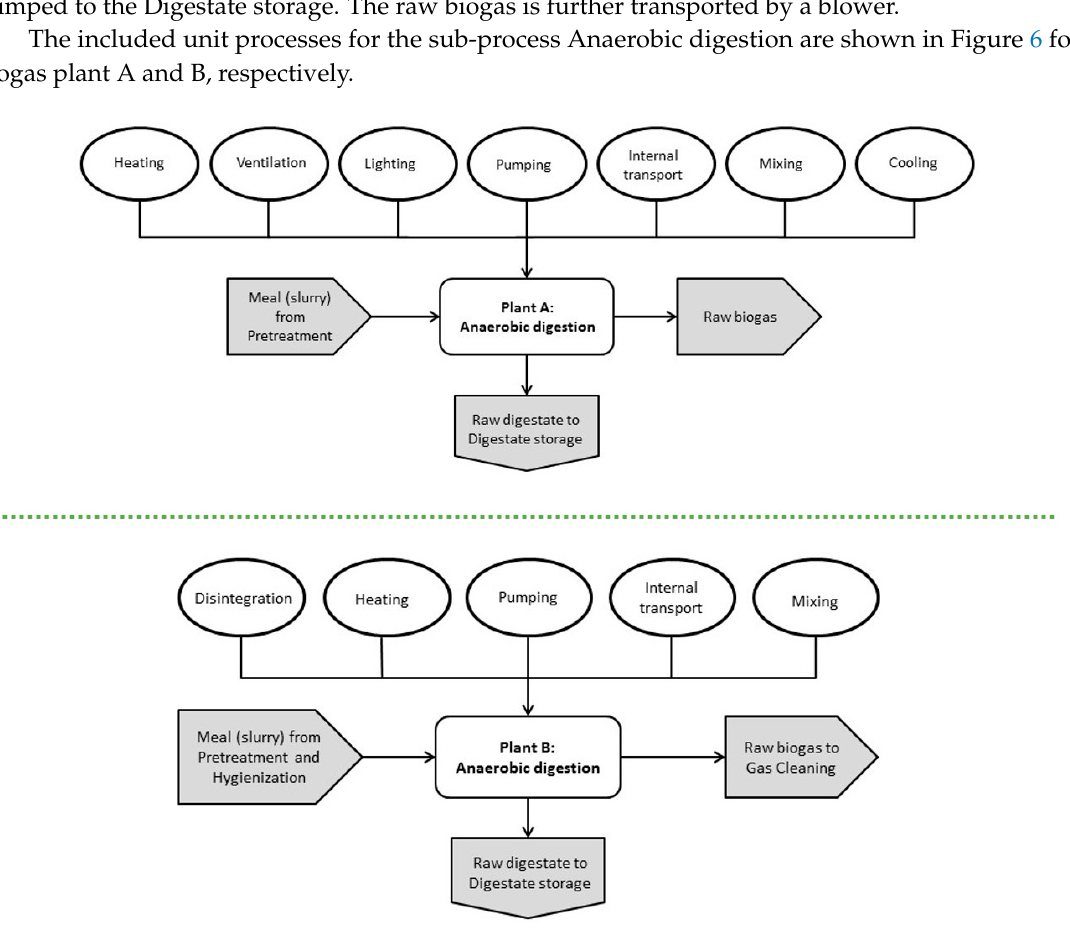
Figure 6. The connection between the sub-process anaerobic digestion and unit processes at biogas plant A and B, respectively.